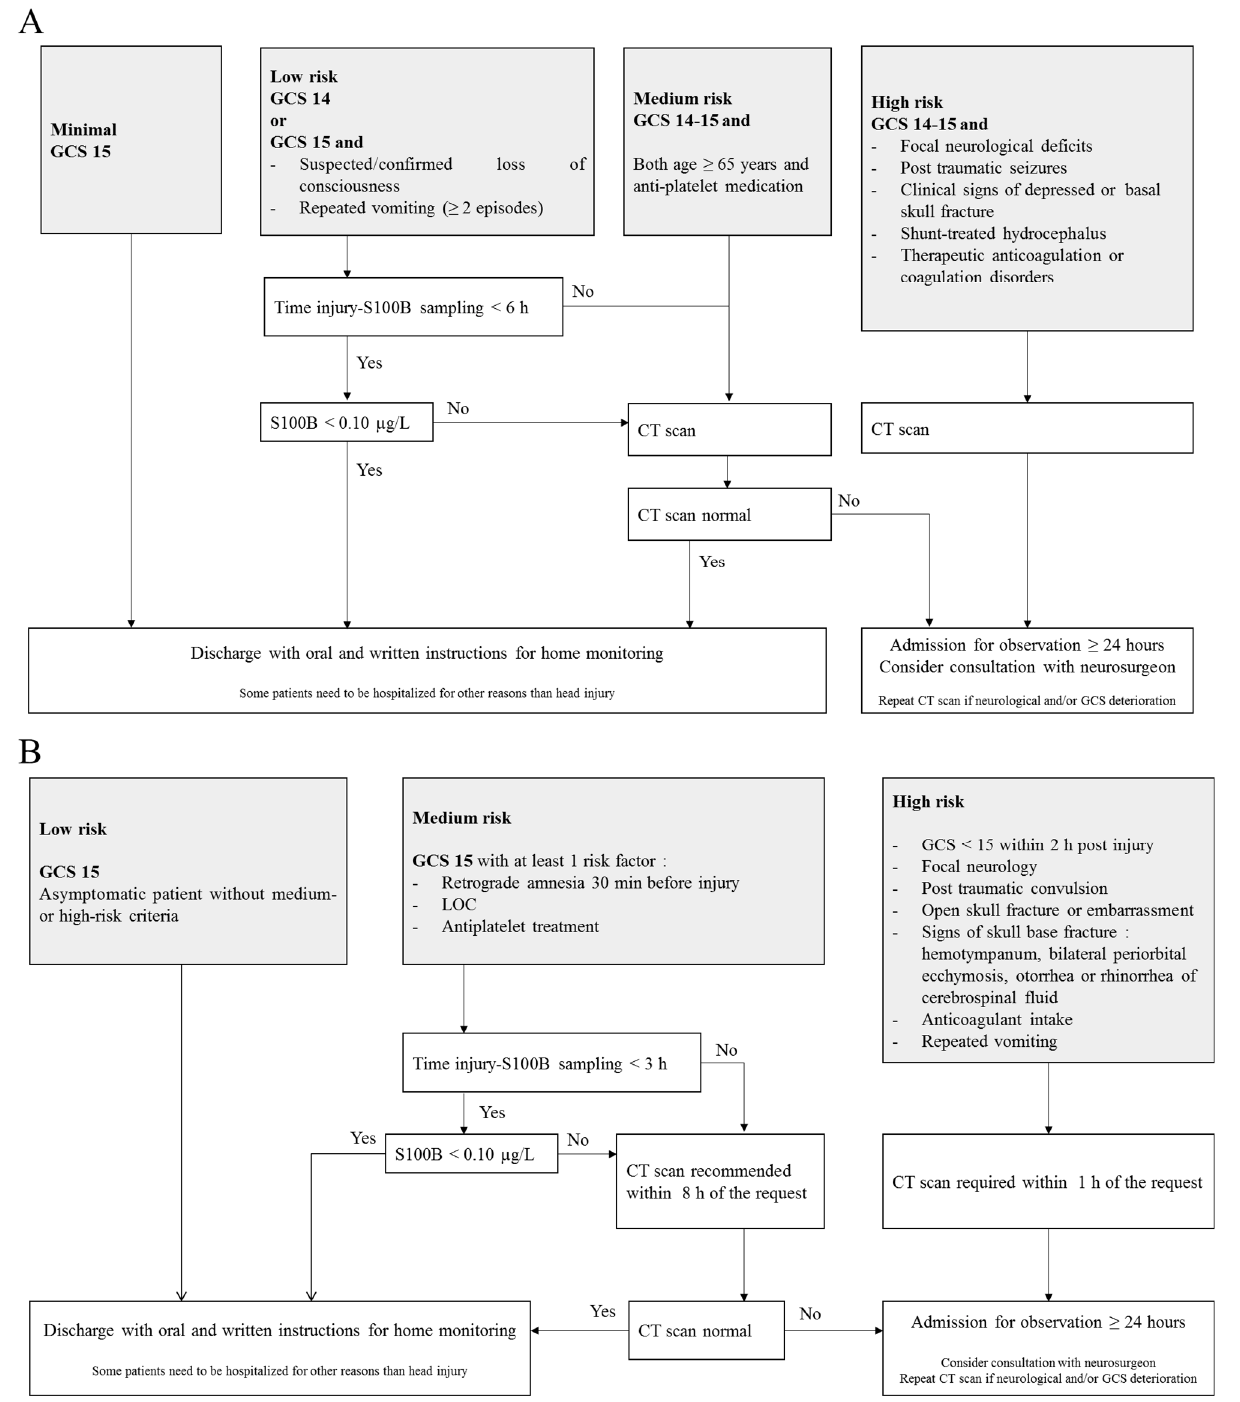
Figure 1. Scandinavian ( A ) and French guidelines ( B ) for the management of patients with mild traumatic brain injury. CT scan: Computed tomography scan; GCS: Glasgow Coma Scale; LOC: Loss of Consciousness.